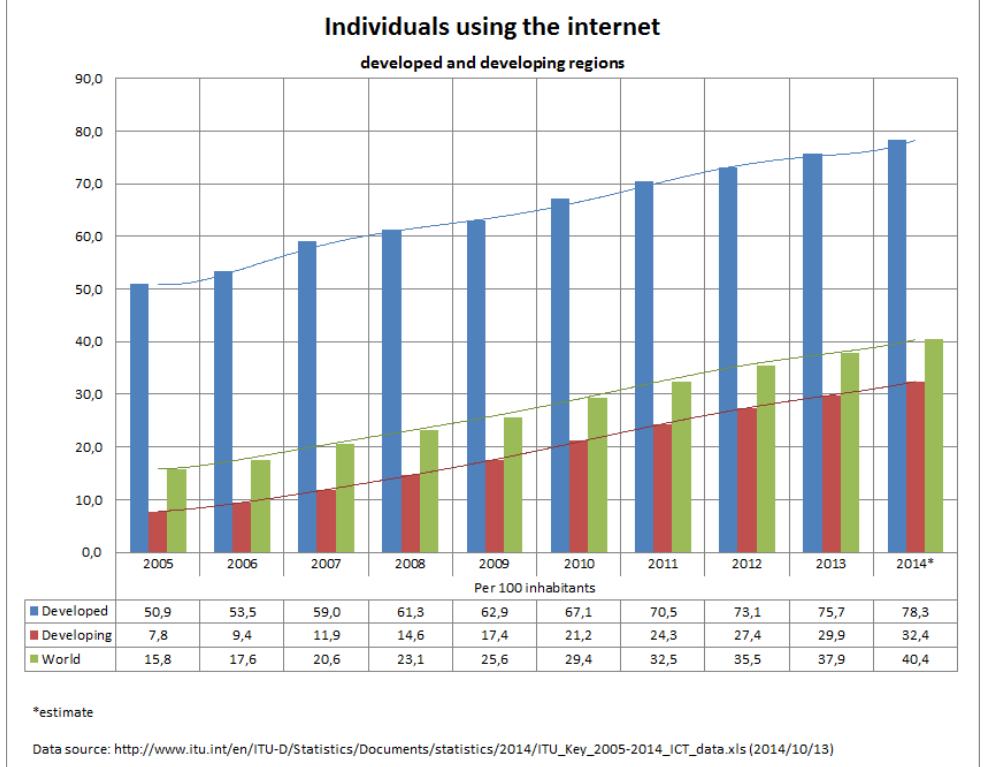
Figure 2. Individuals using the internet (developed and developing regions) Above all the reasons for this are attributed to the individual economic situation, but also to the technical conditions in developing countries especially for the poorer sections of the population. But the access gap isn’t only a topic between developing and industrialized countries; there is also an access gap within industrialized countries. Although in Germany about 75% of the population have access to the internet, it can be seen that “despite numerous initiatives the digital divide